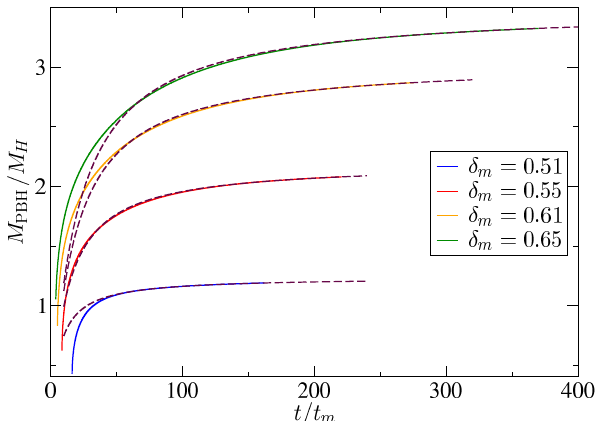
Figure 16. Evolution of the mass of the PBH for w = 1/3 after the formation of the apparent horizon for the profile of Equation (83) with q = 1 and λ = 0. The colour lines correspond to different values of initial amplitudes δ m . The dashed line corresponds to the analytical fit using Equation (56). Threshold value δ c = 0.49774 ± 2 × 10 − 5